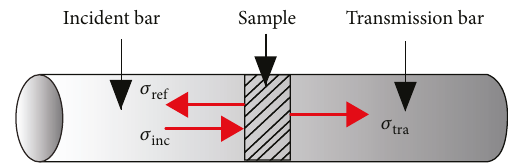
Figure 3: Schematic diagram of the stress in pressure bars. σ incident stress; σ ref : re fl ected stress; σ tra : transmitted stress.